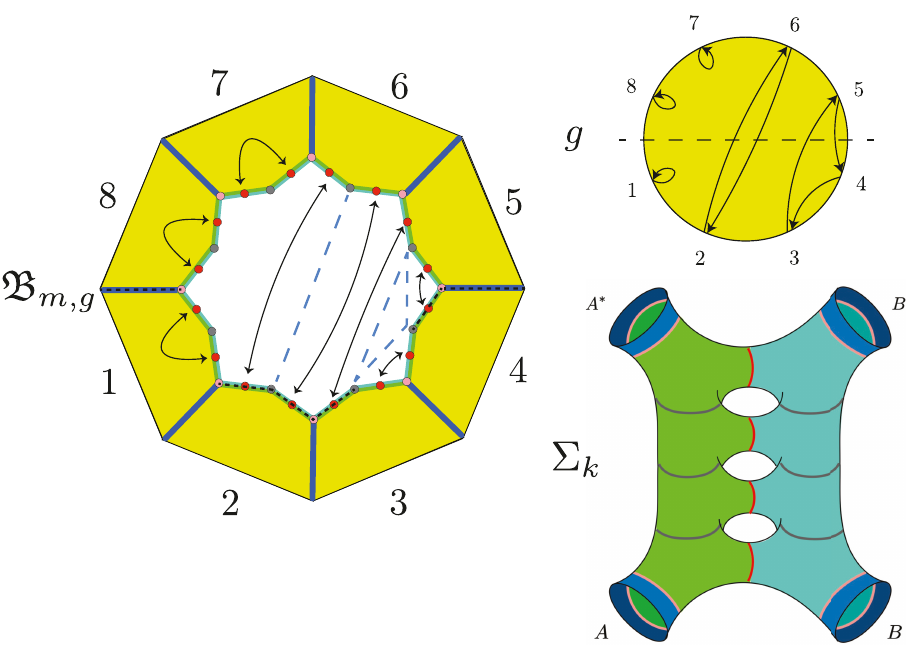
) (e.g. m = 8 ) involves Euclidean saddles Figure 6 . The computation of h ρ m/ 2 | ρ m/ 2 i = tr( ρ m AB AB AB constructed by gluing m copies of the original fixed area saddle in different ways. E.g., a particular saddle B is in a one-to-one correspondence to permutation g acting on m elements. Here, we m,g depict one such example. The Z symmetric slice (black dotted) is then a Cauchy slice Σ 2 Lorentzian evolution and consists of 2 k copies of the entanglement wedge, where k is the number of permutation cycles crossing the horizontal dotted line on the right (here k = 2)